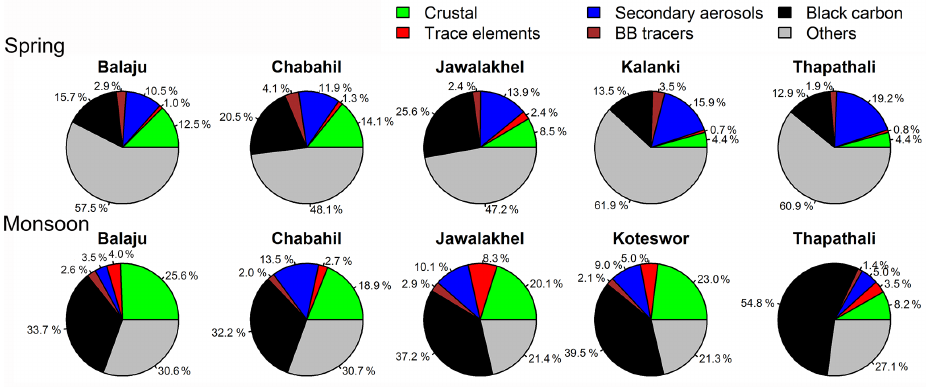
Figure 9. Chemical composition of ambient PM 2 . 5 (crustal elements (Mg, Al, Si, Ca, and Fe), heavy metals (Cr, Mn, Co, Cu, Zn, As, Hg, ) , biomass burning tracers (K and Cl), and others (including organic material)) observed at and Pb), secondary ions (NH + , SO 2 − , and NO − 4 4 3 six sites in the Kathmandu Valley for two sampling periods in the spring season (upper panel) and monsoon season (lower panel) in